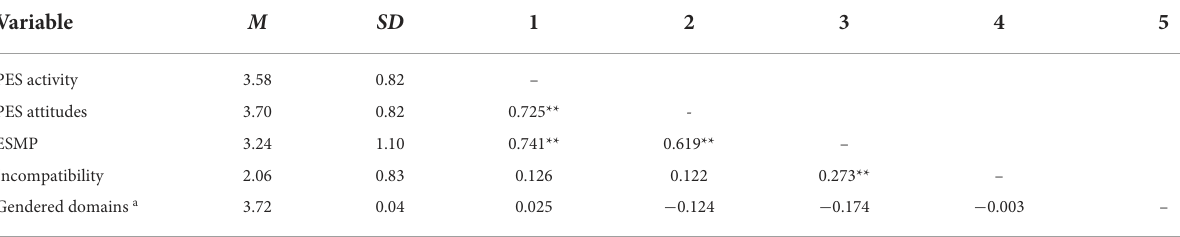
TABLE 3 Descriptive statistics and correlations for study 2